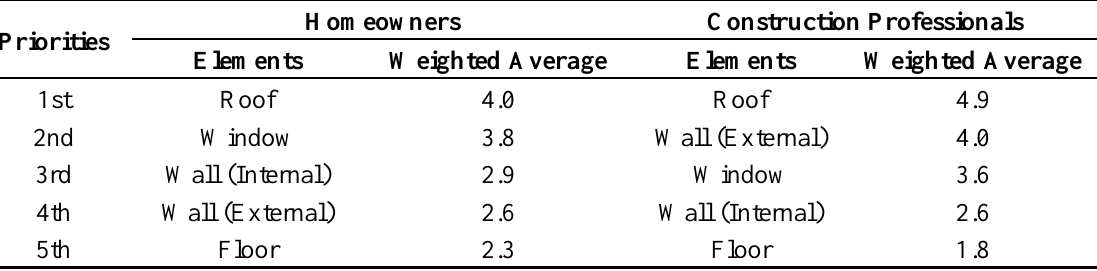
Table 3. Comparative analysis of refurbishment priorities between homeowners and construction